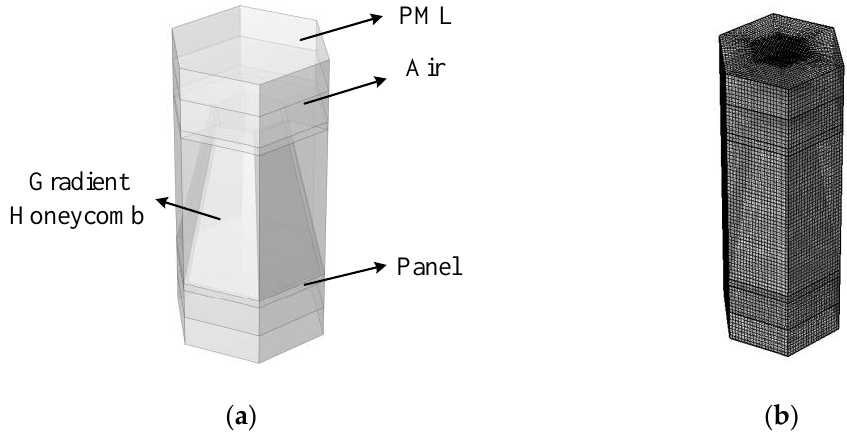
Figure 5. Finite element model and mesh generation.